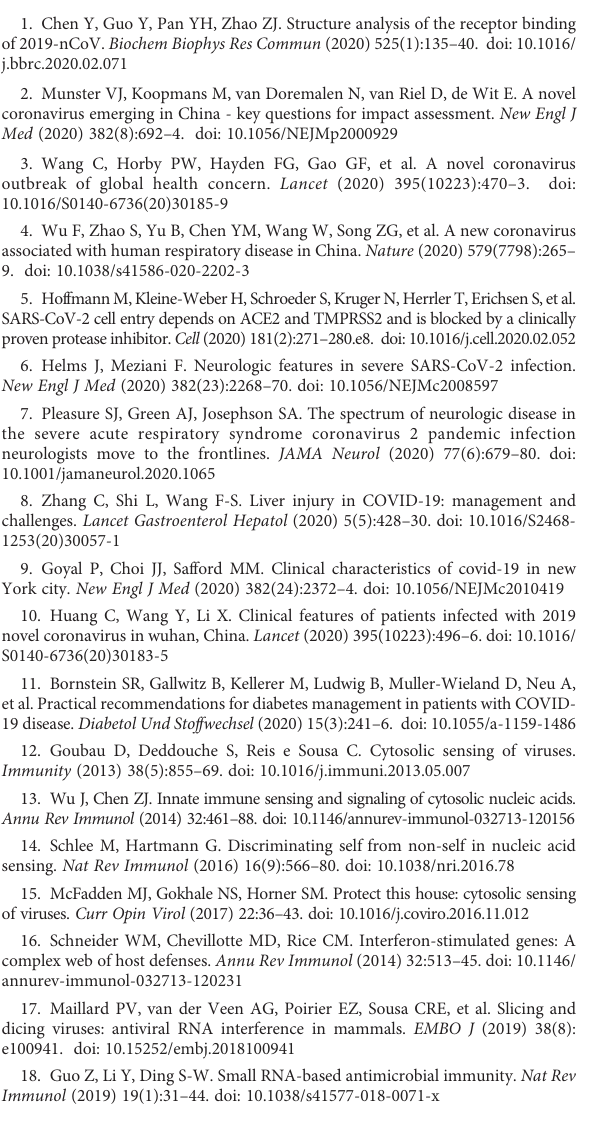
SUPPLEMENTARY FIGURE 3 TheaccumulationofvsRNAsalongSARS-CoV-2genomeinVerocellline. (A) Distribution of 18-35 nt virus-derived sRNAs mapping to positive and negative strand of SARS-CoV-2 genome in control and virus-infected (6 hpi/12hpi)Verocells.ThesmallRNAabundanceispresentedasreadscounts along the viral genome (n=2). (B) Distribution of 22-nt virus-derived sRNAs mapping to positive and negative strand of SARS-CoV-2 genome in control and virus-infected (6 hpi/12 hpi) Vero cells. The 22-nt small RNA abundance is presented as reads counts along the viral genome. Arrows represent the locus where read sequences are analyzed (See Figure 4B) (n=2). SUPPLEMENTARY FIGURE 4 The size distribution of vsRNAs along viral genome in SARS-CoV-2 infected cell lines. (A) Size distribution and abundance of 18-35 nt vsRNAs in SARS- CoV-2 infected Calu-3, PC-9, A549-hACE2 cells at different post-infection time points from Pawlica et al., 2021. Pie plots represent vsRNAs initiated